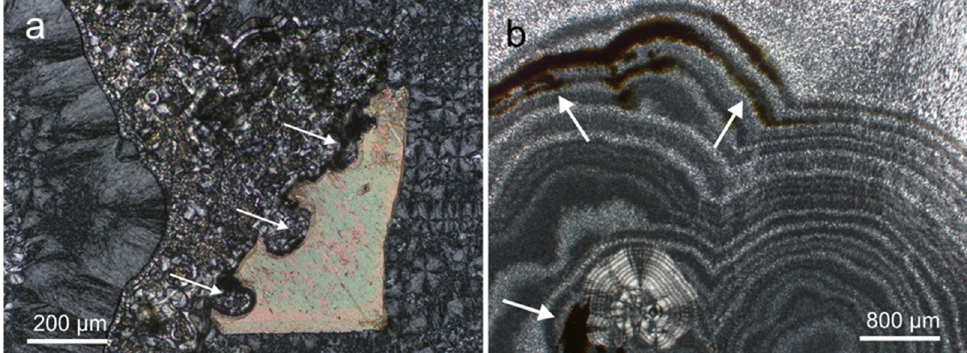
Figure 8. Micrographs in transmitted light (crossed polars) of non-silica phases in the agates from El Picado: ( a ) calcite grain (sample ACu3), which is partially corroded by SiO 2 (arrows); ( b ) intercalation of dark banded manganese oxides/hydroxides (sample ACu2) arranged along the chalcedony banding (see arrows) pointing to simultaneous accumulation and precipitation from mineralizing fluids.